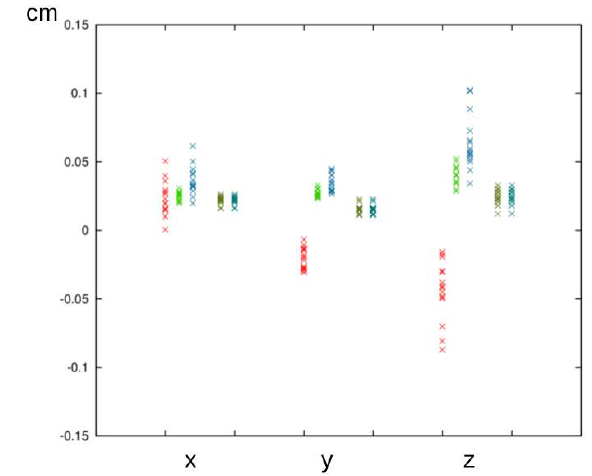
Figure 4: Scatter plot of “pizza” test marker errors and “logo” control point marker errors grouped by x-, y-, and z-coordinate. Red: systematic deviation of test points; green: standard devia- tion of test points from random deviation only; blue: standard de- viation of test points from both systematic and random deviation; dark green: standard deviation of control points from random de- viation only; cyan: standard deviation of control points from